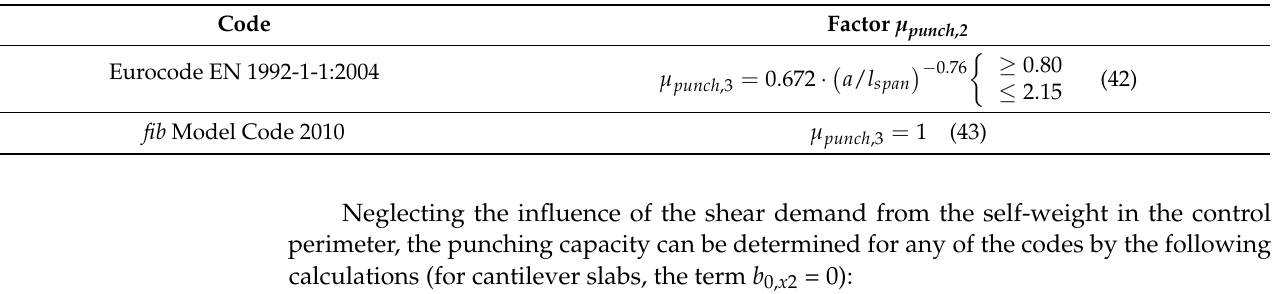
Table 4. Factor ( µ punch ,3 ) related to the ratio a / l span